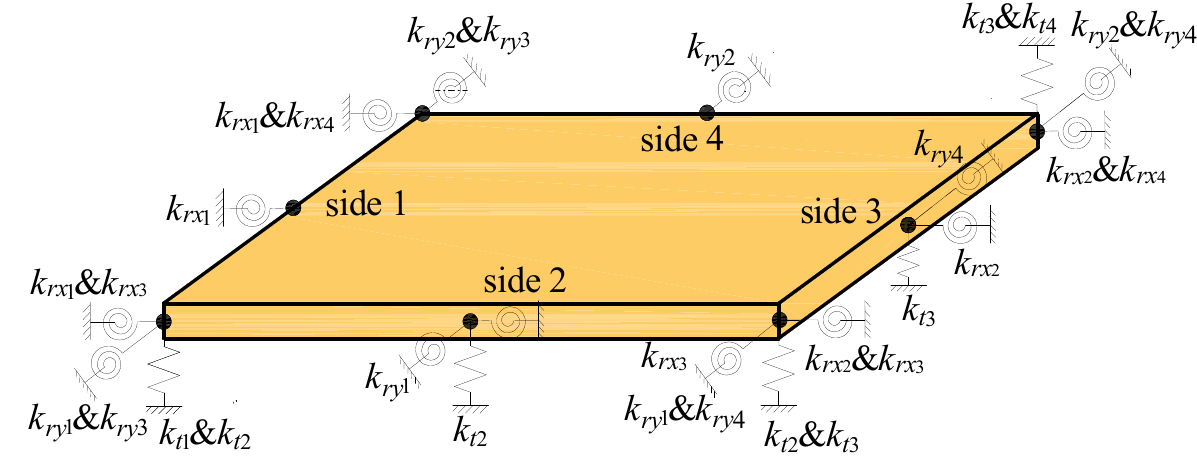
Figure 3. Arrangement of boundary springs.